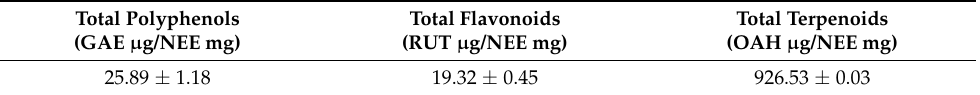
Table 1. Quantitative analysis of NEE major phytochemical compounds.